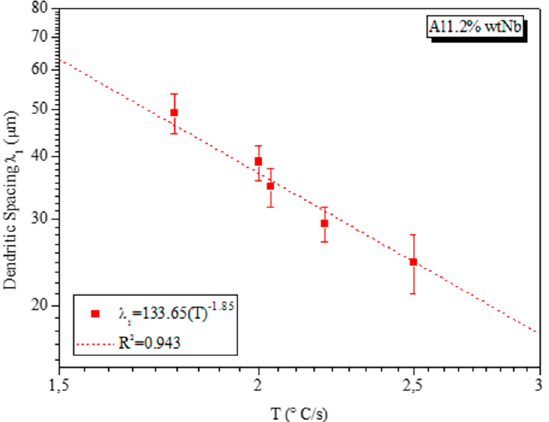
Figure 10. Experimental equation of the primary dendritic spacing as a function of the cooling rate for Al–0.8 Nb (wt.%).